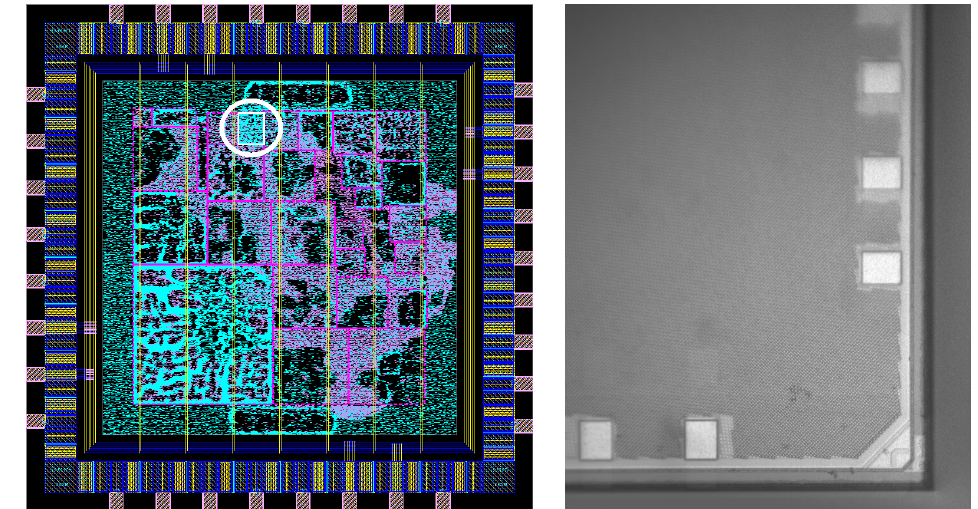
Figure 5: Layout of the 65 nm ASIC with the PRESENT-80 core highlighted in white (left) and a microscopic photograph of the bottom right corner of the chip